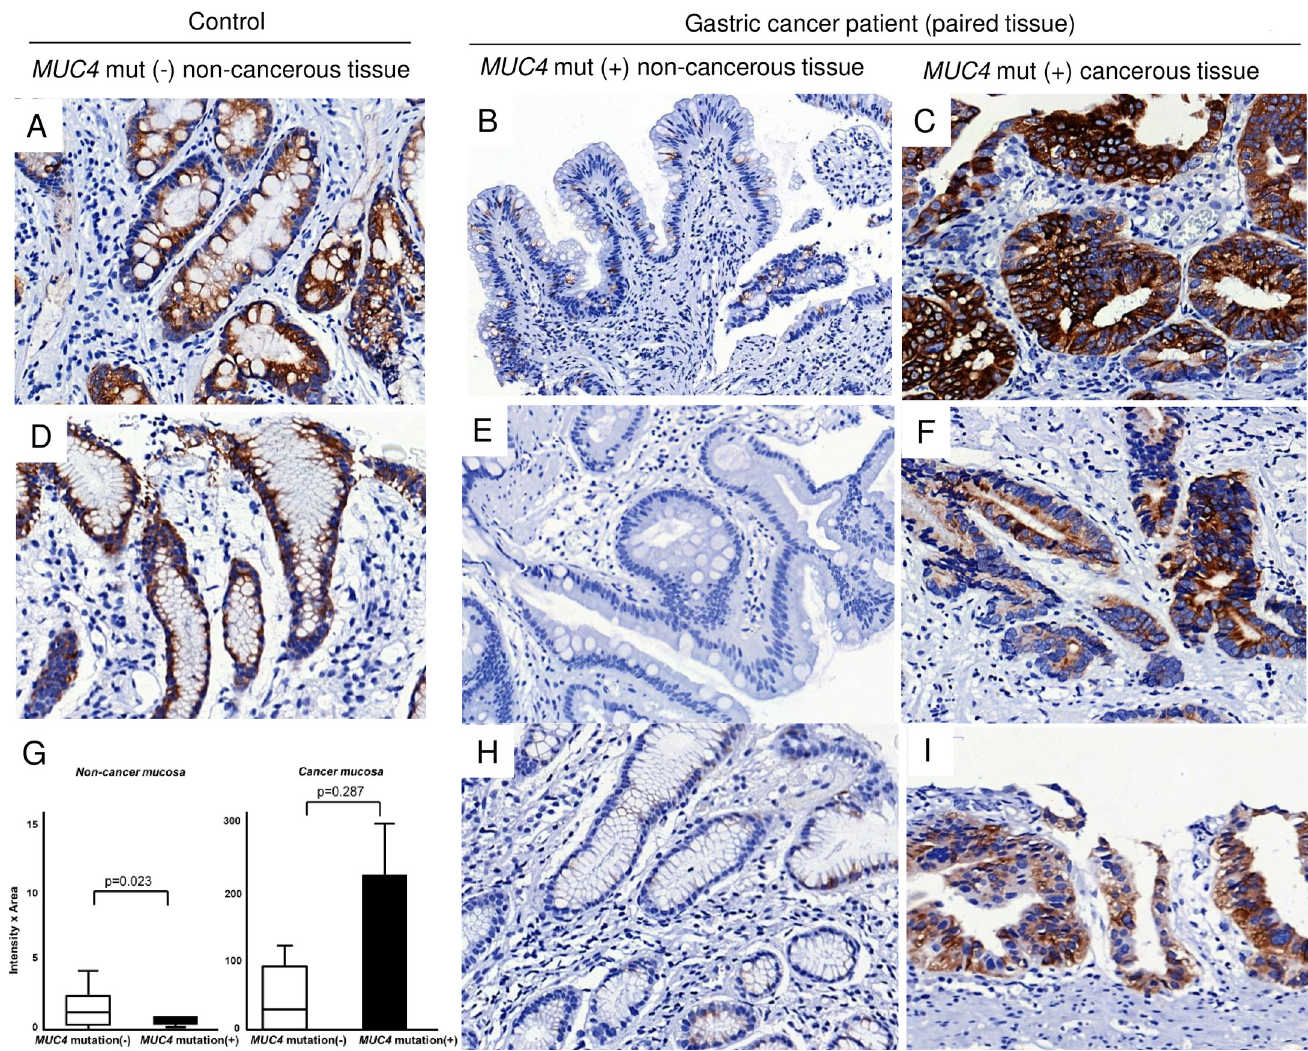
Fig 3. Representative photomicrographs of IHC for MUC4 in noncancerous and cancerous gastric mucosal tissue of Family No. 14 (original magnification A-F, H, and I × 400). Panel A is tissue of #50 (participant number); B & C #51; D, #54; E & F, #52; H & I, #53. Intensive staining (brown) of MUC4 in noncancerous tissue (A, D) in the representative MUC4 variant-negative control is shown compared to absent or faint immunoreactivity of noncancerous tissue in MUC4 variant-positive gastric cancer patients (B, E & H). The paired cancer tissue (C, F and I) of B, E and H show intense and diffuse staining of MUC4 . G, MUC4 immunointensity in MUC4 variant-positive noncancerous mucosa was weaker than that in the MUC4 variant-negative (left). Despite an increased tendency of immunointensity in MUC4 variant-positive cancer tissue, no statistical significance was observed (right). The white bar represents MUC4 variant-negative, while the black bars denote MUC4